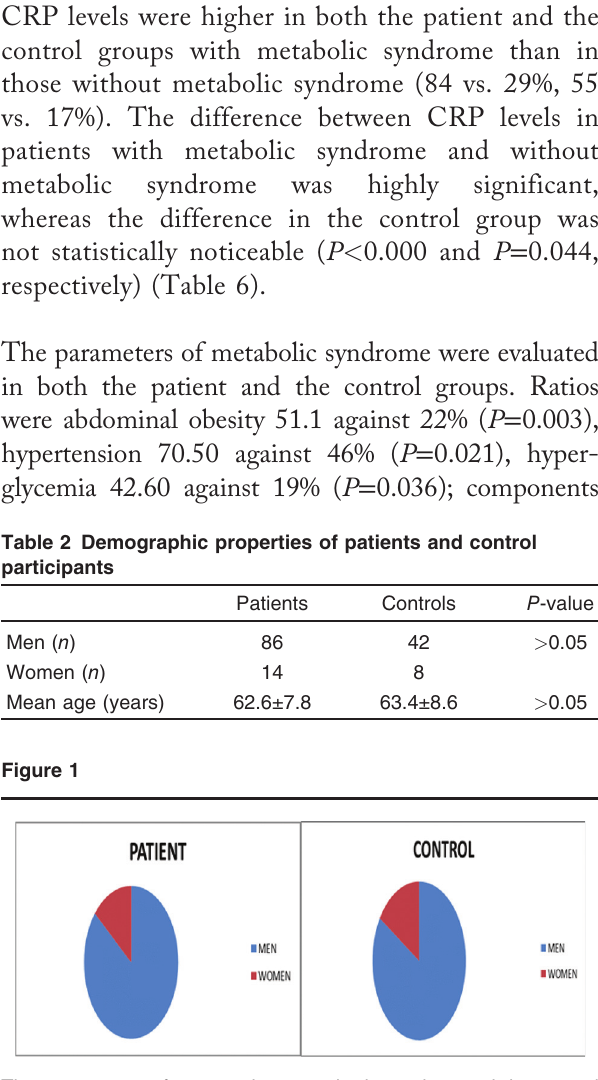
The percentage of men and women in the patient and the control groups.